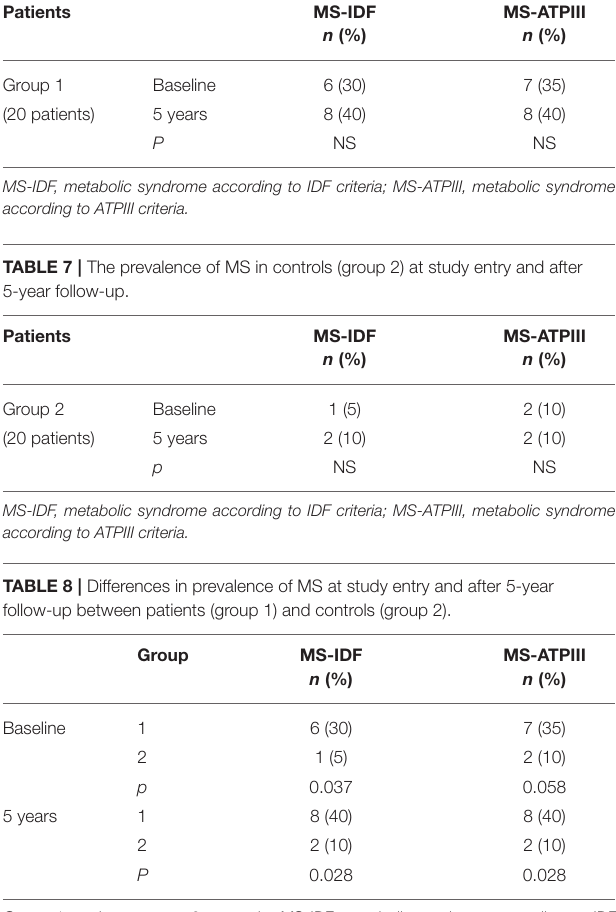
TABLE 4 | Clinical features of controls (group 2) at baseline and after 5-year follow-up. Parameters